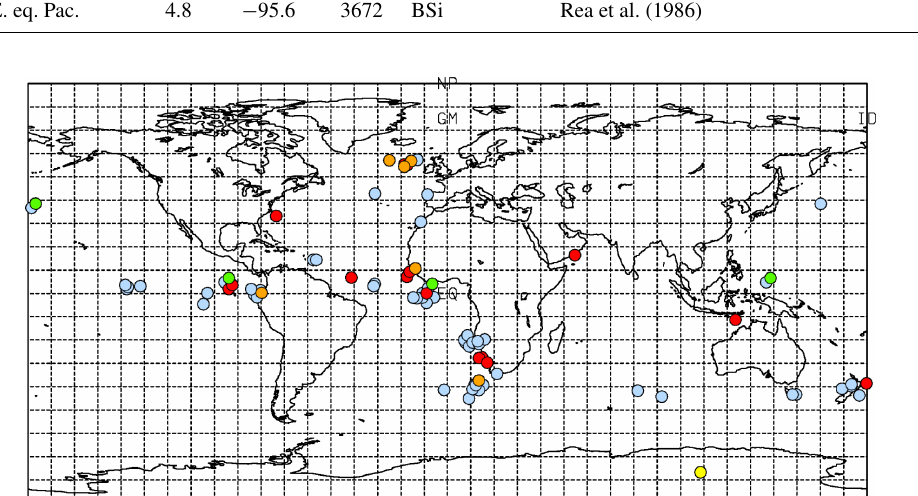
Figure 5. Locations of the palaeoclimate observations (sediment core, ice core) as used in the inverse approach: atmospheric CO 2 (yellow), δ 13 C benthic (red), δ 13 C planktonic (orange), BSi wt% (green), and CaCO 3 wt% (blue).